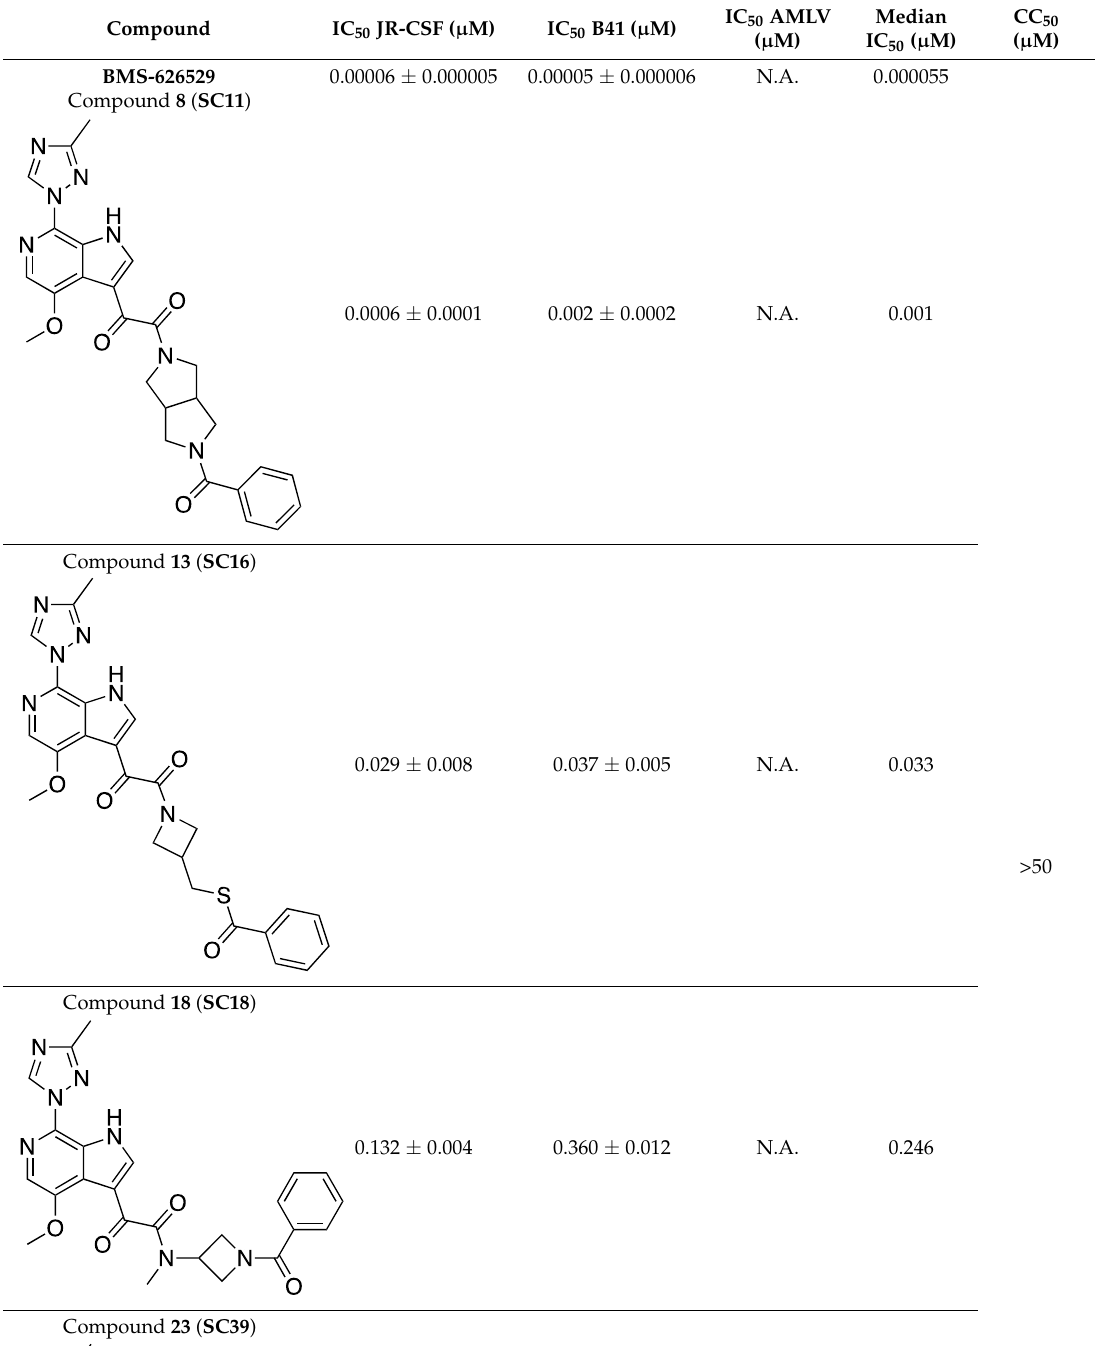
Table 1. Specificity and potency of compounds against HIV-1 JR-CSF , HIV-1 B41 , and AMLV-pseudotyped HIV-1. N.A. = not active. The chemical structures were drawn with ChemDraw Ultra